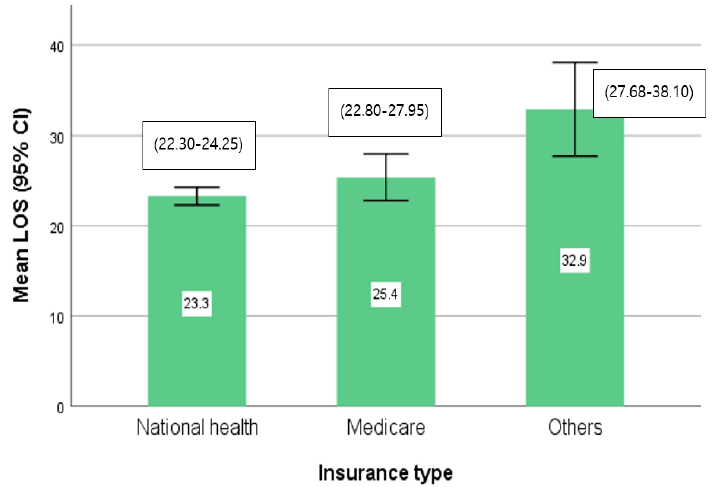
Figure 1. Mean length of stay (LOS) according to insurance type.